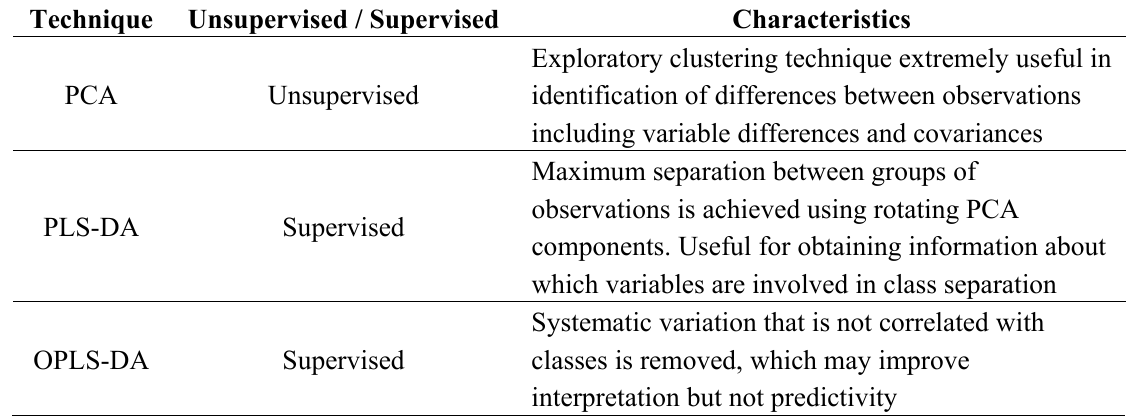
Table 3. A summary of commonly applied multivariate data analysis approaches in metabolomics studies. Abbreviations: PCA, principal component analysis; PLS-DA, partial discriminant analysis; HCA, hierarchical cluster analysis; RF, Random